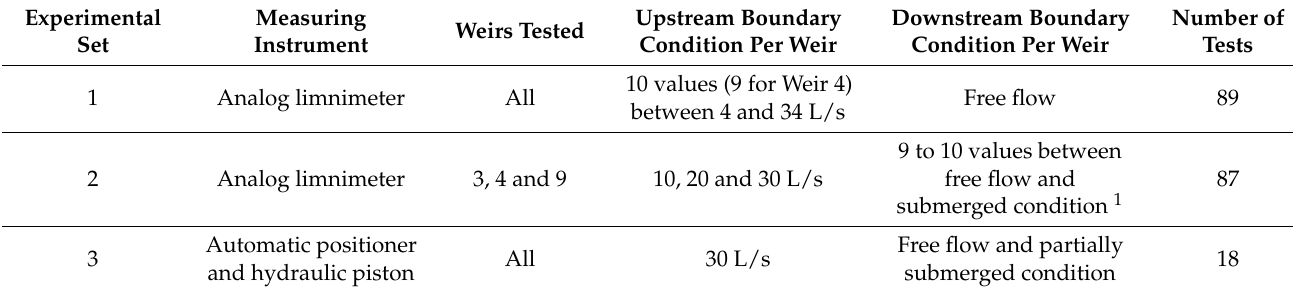
Figure 1. Geometry of the weirs tested. Dimensions are shown in mm. The thickness of the stainless steel plats is 3 mm. Table 1. Summary of the experimental tests.